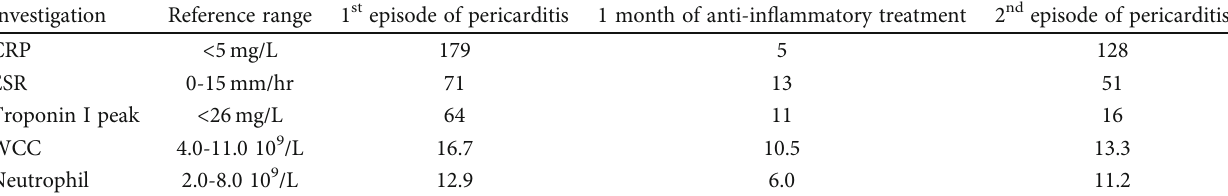
Table 1: Table summarising the key investigations of the